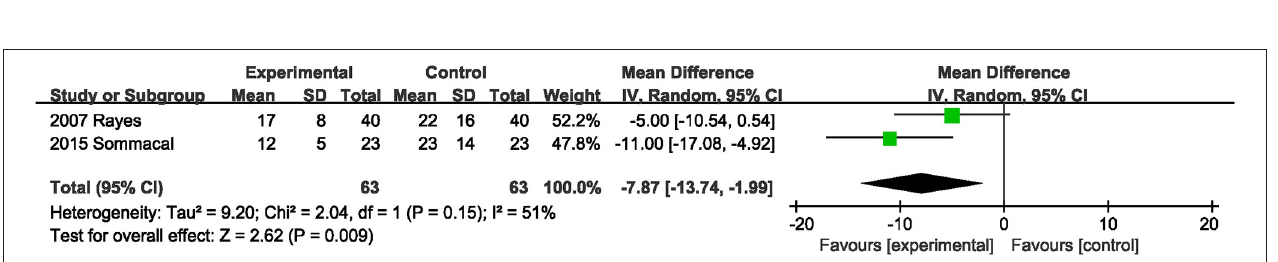
FIGURE 6 | Effect of probiotics or synbiotics supplementation on the length of hospital stay.